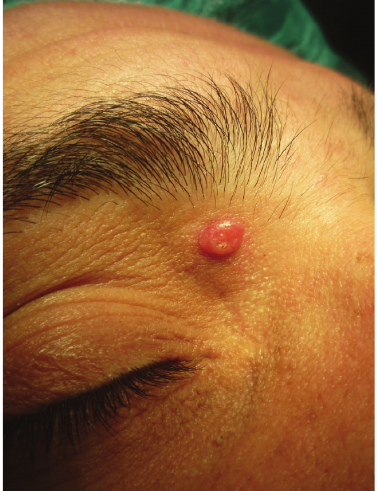
Figure 1: Clinical features of the skin lesion on the upper eyelid.